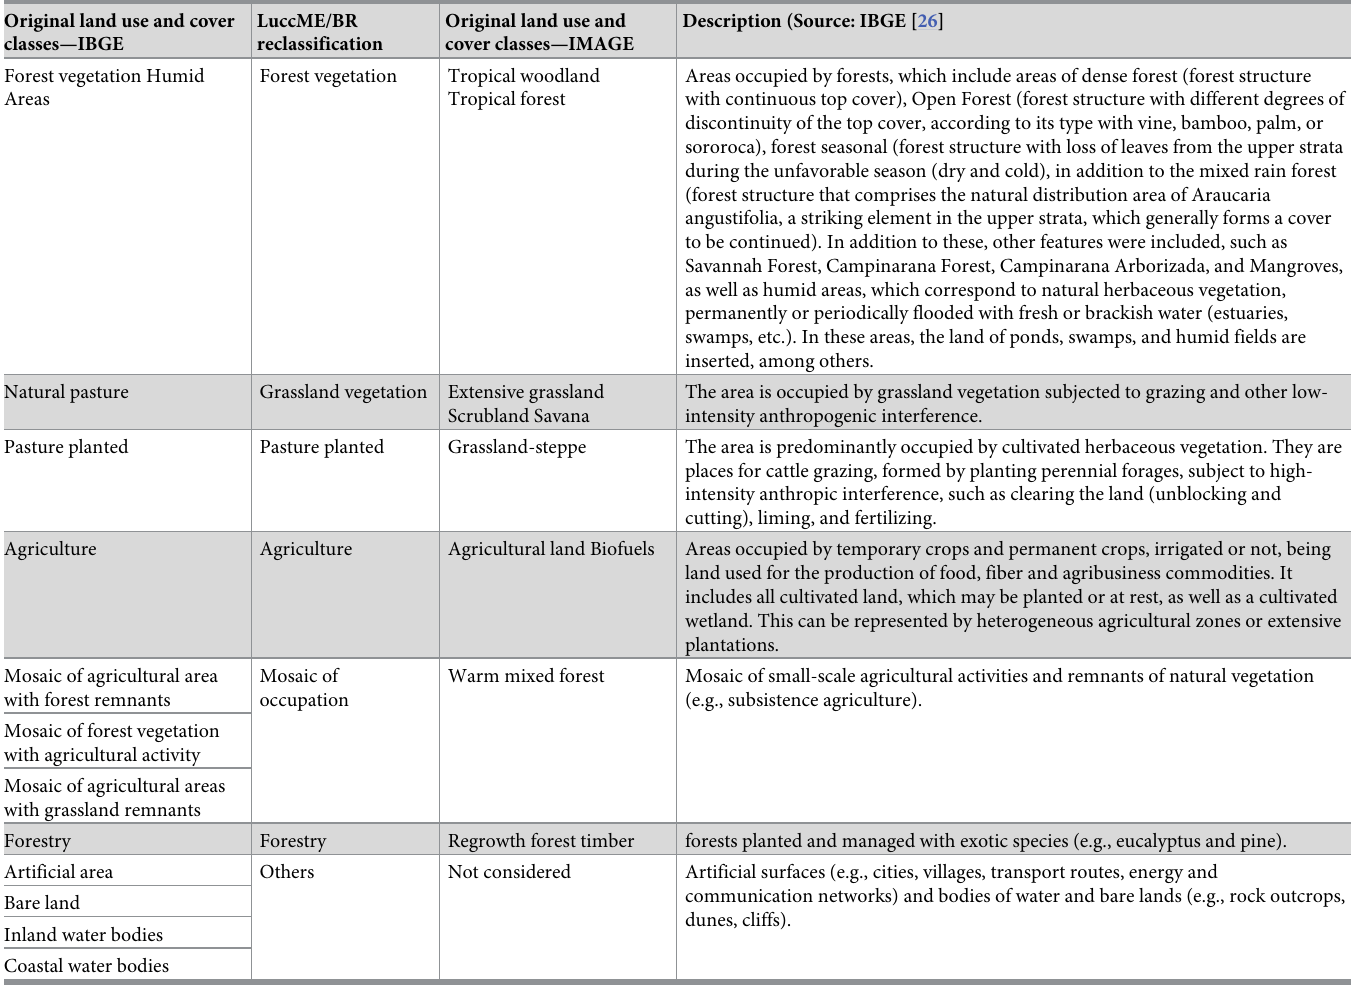
Table 1. Land use and land cover classes. Original land use and cover